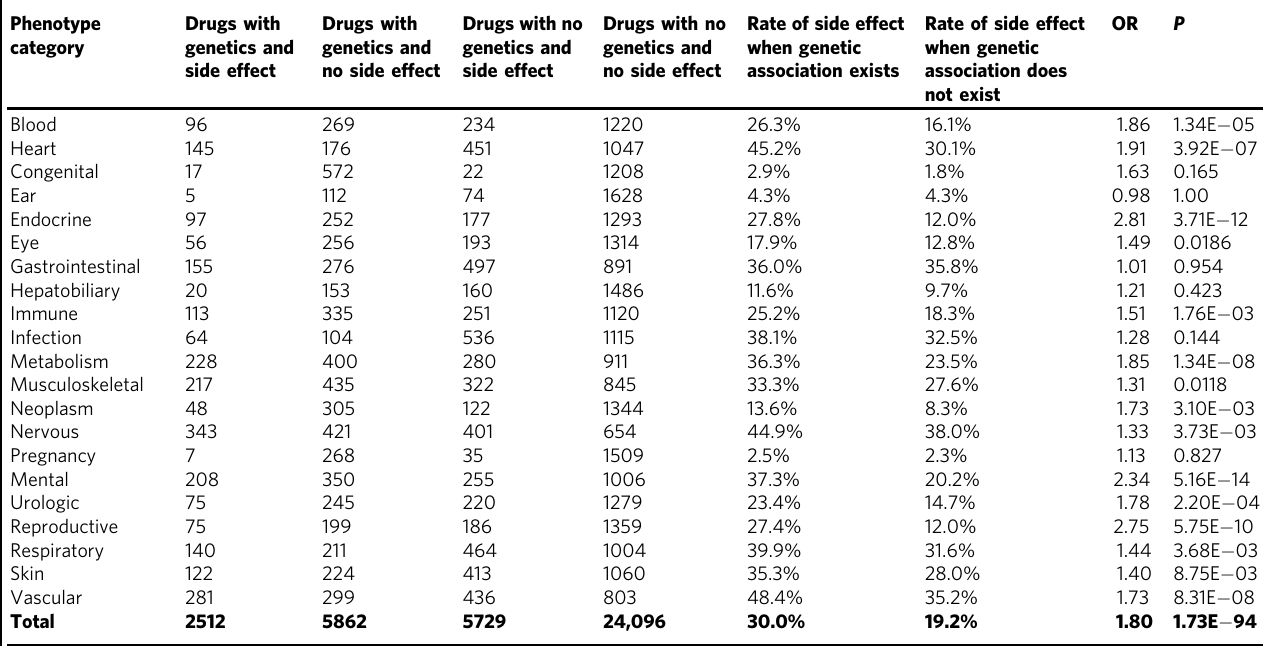
Table 1 Analysis of enrichment between genetic phenotypes and side effects in individual organ systems Phenotype